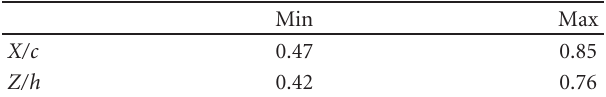
Table 1: Nacelle position